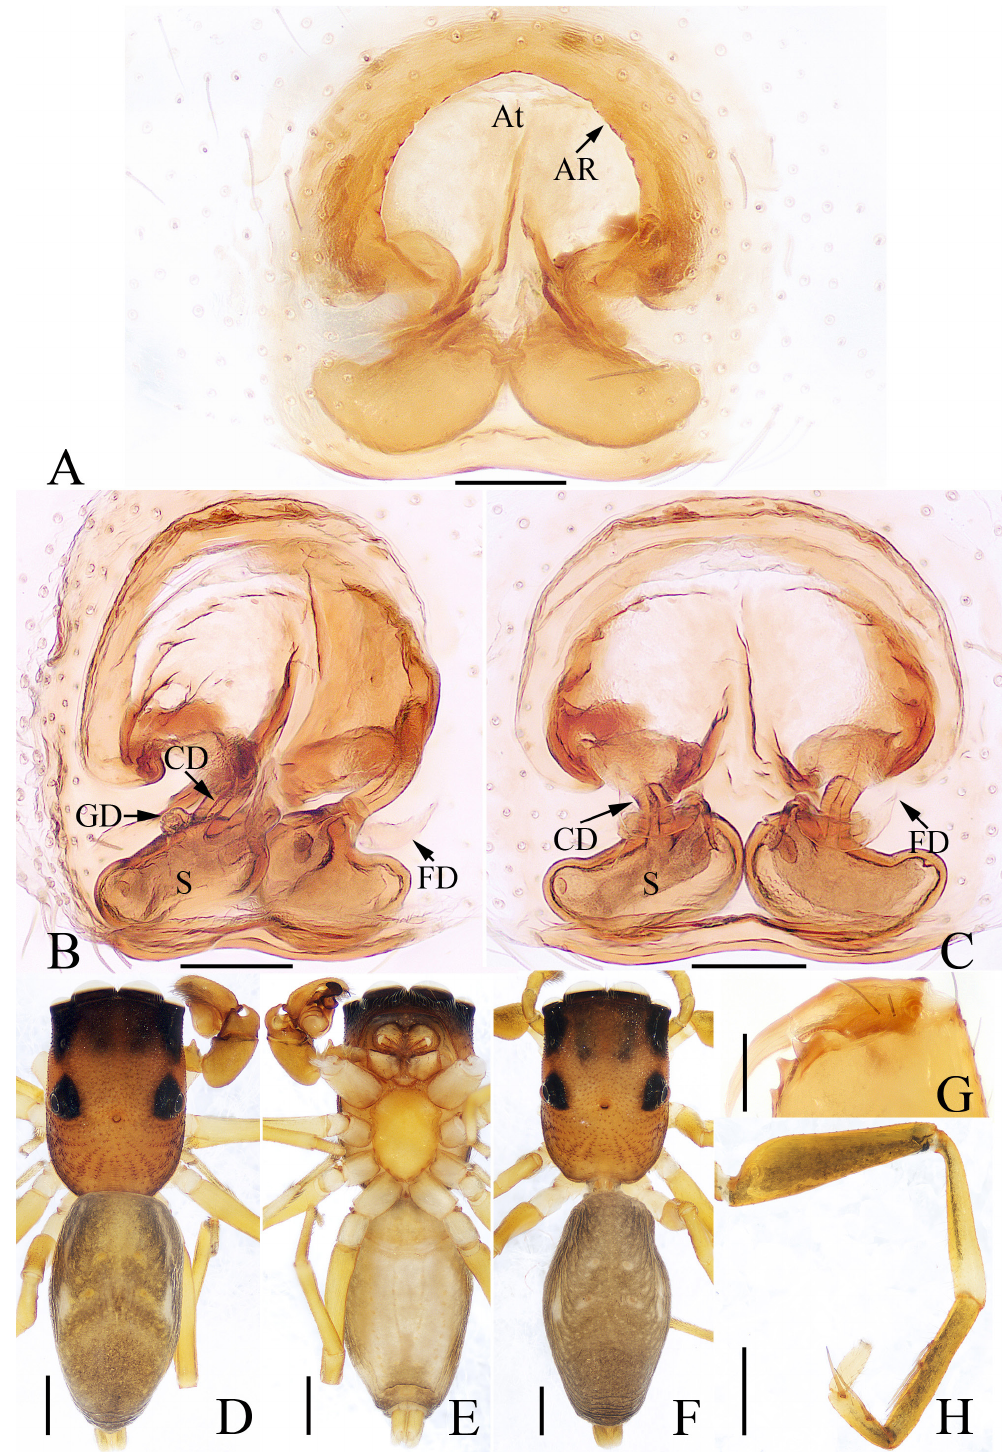
Fig. 6. Synagelides leigongensis sp. nov. A–C, F . Paratype, ♀ (TRU-Salticid-0014). D–E, G–H . Holotype, ♂ (TRU-Salticid-0012). A . Epigyne, ventral view. B . Epigyne, dorsolateral view. C . Epigyne, dorsal view. D . Habitus, dorsal view. E . Habitus, ventral view. F . Habitus, dorsal view. G . Chelicerae, dorsal view. H . Leg I, prolateral view. Abbreviations: see Material and methods. Scale bars: A–C, G = 0.1 mm; D–F, H = 0.5